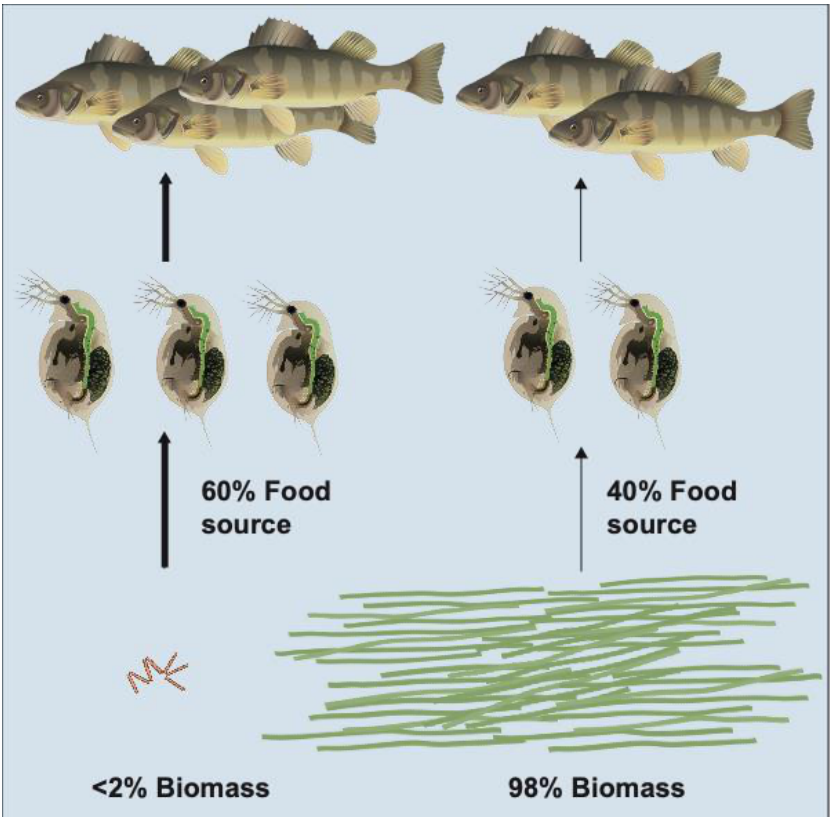
Figure 2. Schematic drawing of an ecosystem dominated by Aphanizomenon and Daphnia . Although it appears that Daphnia is feeding on Aphanizomenon , fatty acid analyses of Daphnia reveals that 60% of the food came from cryptophytes and diatoms which constitute less than 2% of the total standing phytoplankton biomass.